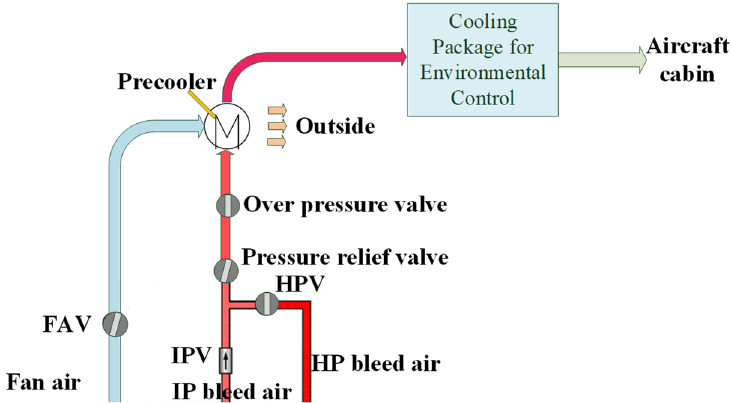
Figure 9. The installation diagram of the ECS test piece.